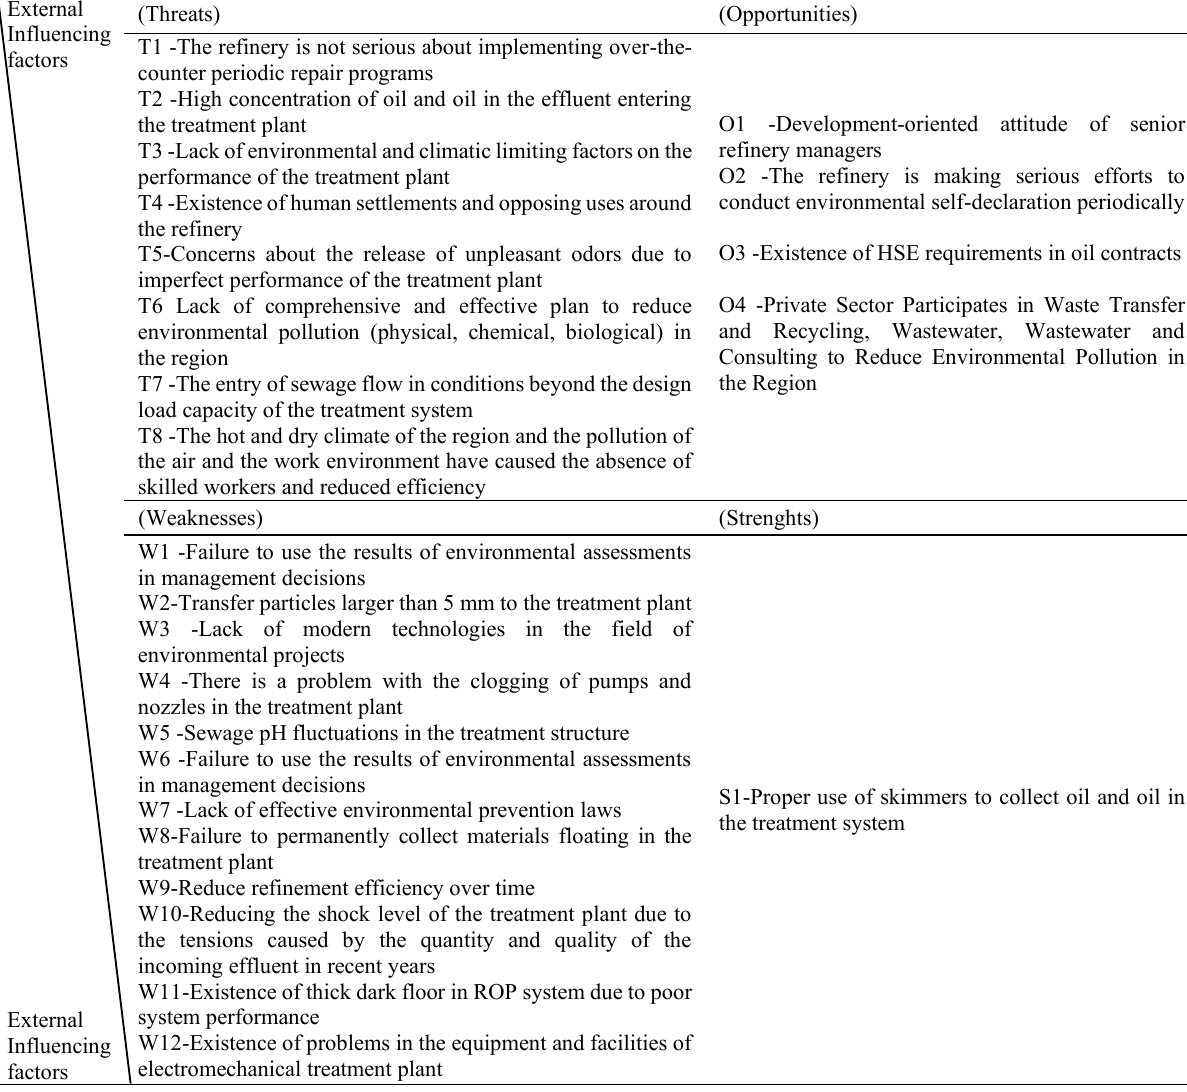
Table 6. Raw SWOT matrix of reviewed strategic factors in Abadan Oil